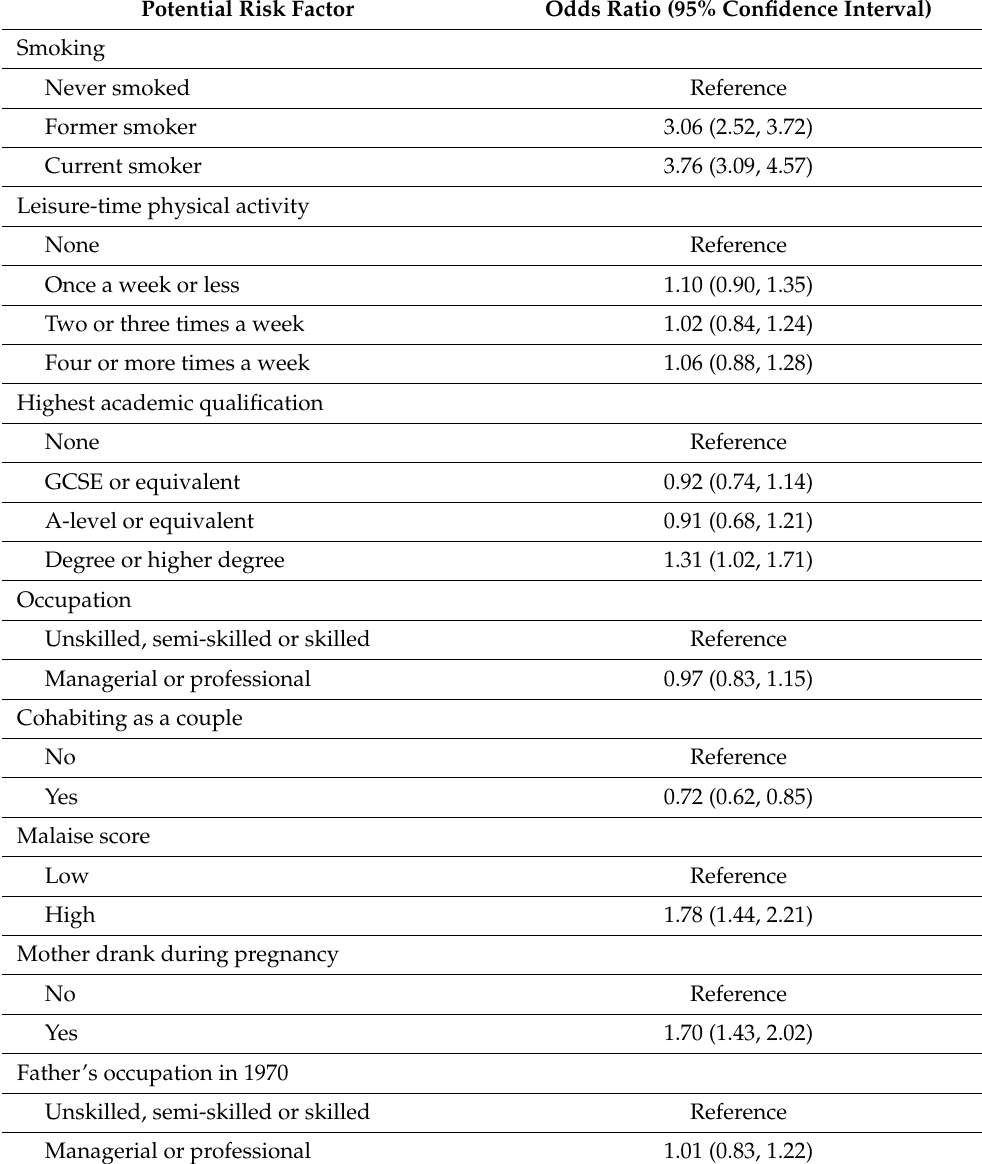
Table 3. Longitudinal associations of modifiable and non-modifiable risk factors with problematic drinking in